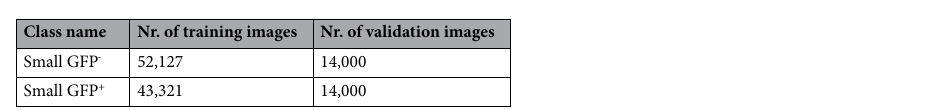
Figure 5. Dataset assembly. ( A ) The scatterplot shows a measurement of dissociated retina (Nrl-eGFP) in soRT-FDC. Axes show the cell size (area in µm 2 ) and the fluorescence expression of Nrl-eGFP. Red, green and gray rectangles indicate regions in the plot which correspond to debris, small GFP + , and small GFP - cells, respectively. Images show examples of the appearance of cells at different locations in the scatterplot. The color code indicates the density of data points. Scale bars: 10 µm. ( B ) Images show three different measurements with various brightness levels. To evaluate the background brightness and image noise, a region above the channel was used (red rectangle). Scale bars: 10 µm. ( C ) Histogram shows the absolute tilt of contours of small GFP + events (same measurement as shown in A ). The red line indicates the median tilt at 13°. Image insets show exemplary phenotypes of cells at low (left) and high (right) tilt. While a low tilt indicates a good alignment with the flow, a tilt of 90° shows a cell aligned orthogonal to the flow direction. Scale bars: 10 µm.